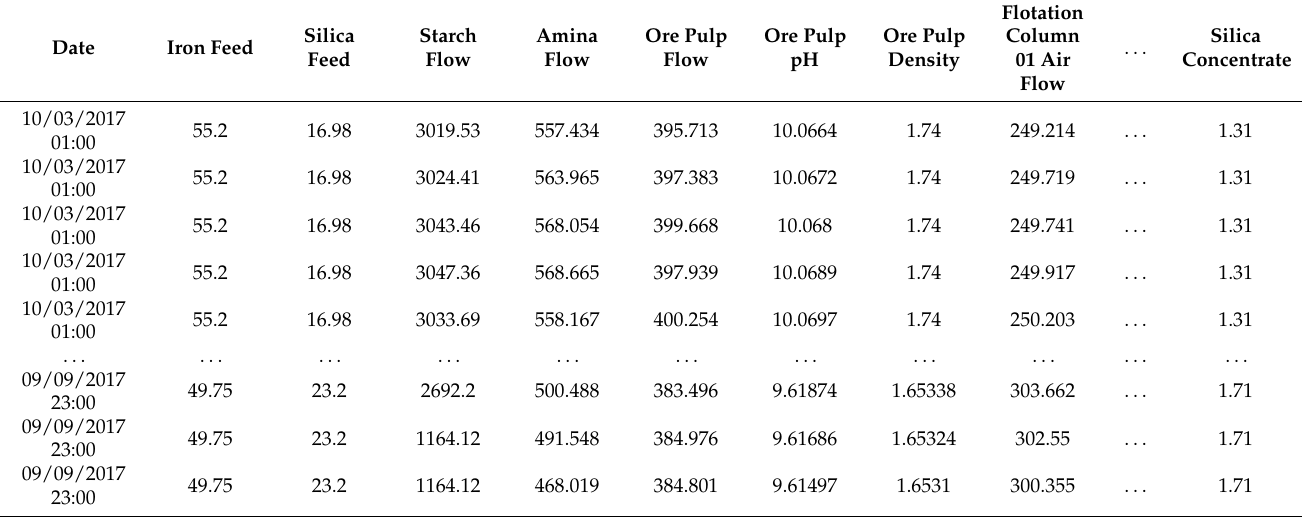
Table 1. A portion of the dataset used in the second experiment